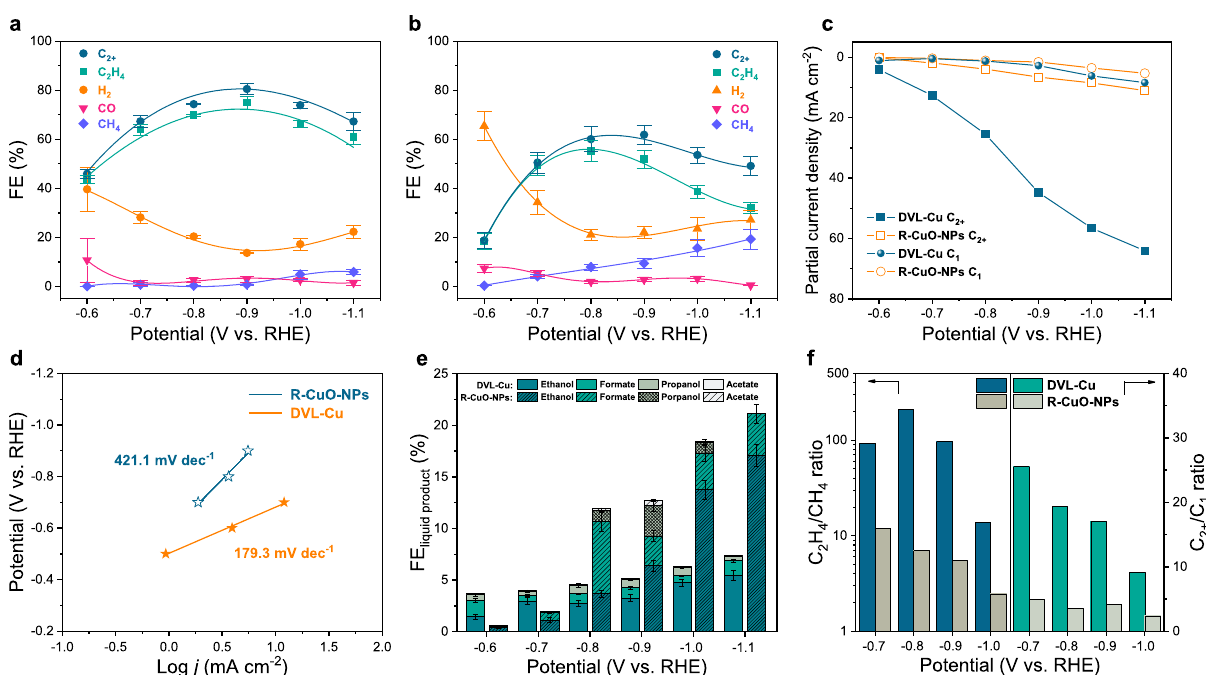
Fig. 4 Electrochemical CO 2 RR performance of DVL-Cu and R-CuO-NPs. a FEs of DVL-Cu. b FEs of R-CuO-NPs. c C 2 + and C 1 partial current densities of DVL-Cu and R-CuO-NPs. d C 2 H 4 partial current density Tafel plots of DVL-Cu and R-CuO-NPs. e FEs of liquid products of DVL-Cu and R-CuO-NPs. f C 2 H 4 /CH 4 ratios and C 2 þ /C 1 ratios for CO 2 RR products of DVL-Cu and R-CuO-NPs. Error bars represent the standard deviation of three independent